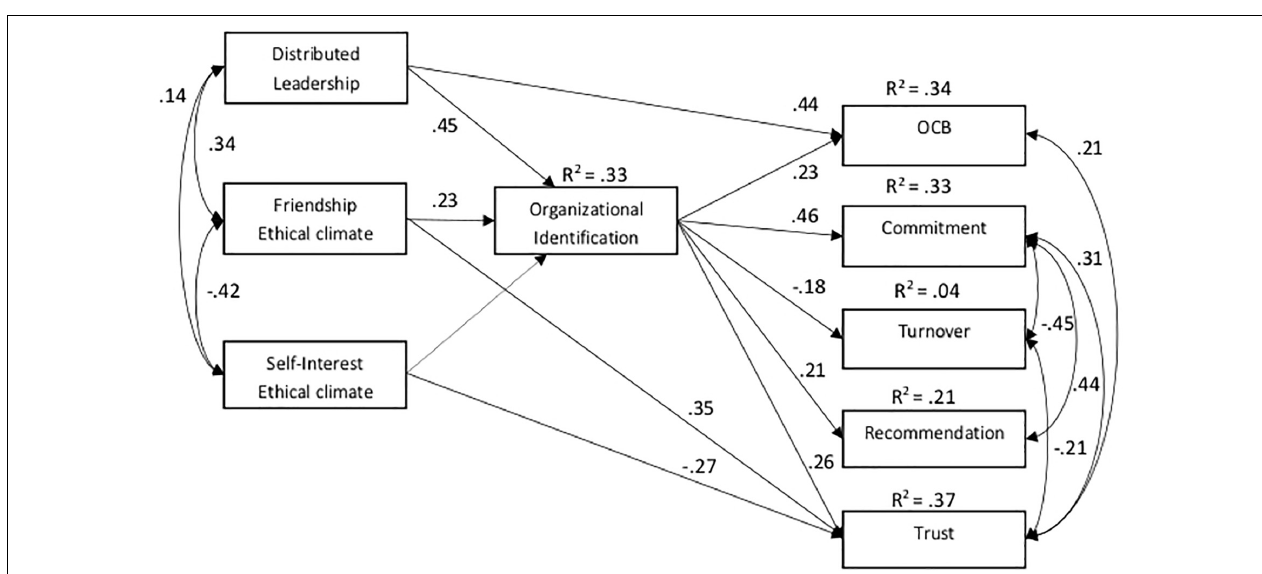
FIGURE 2 | Path analysis of the proposed model.